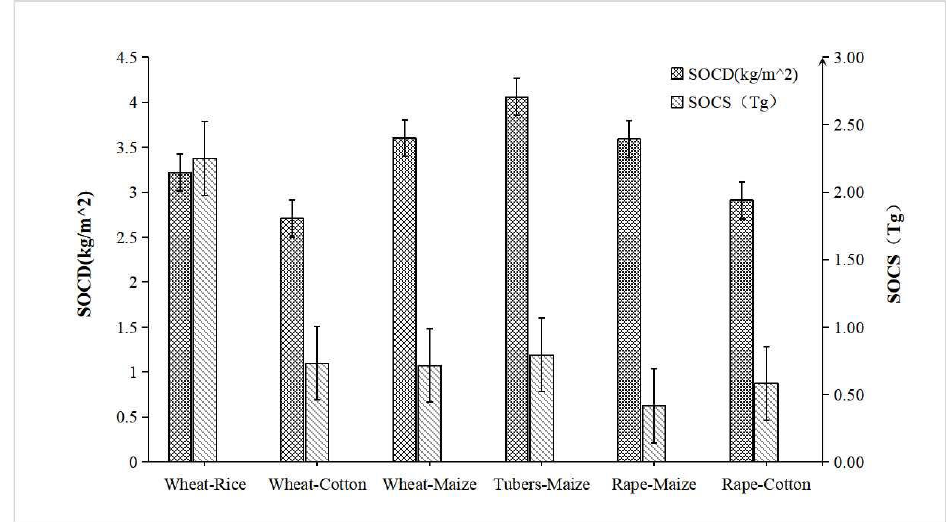
Figure 5. SOCD and SOCS among different crop